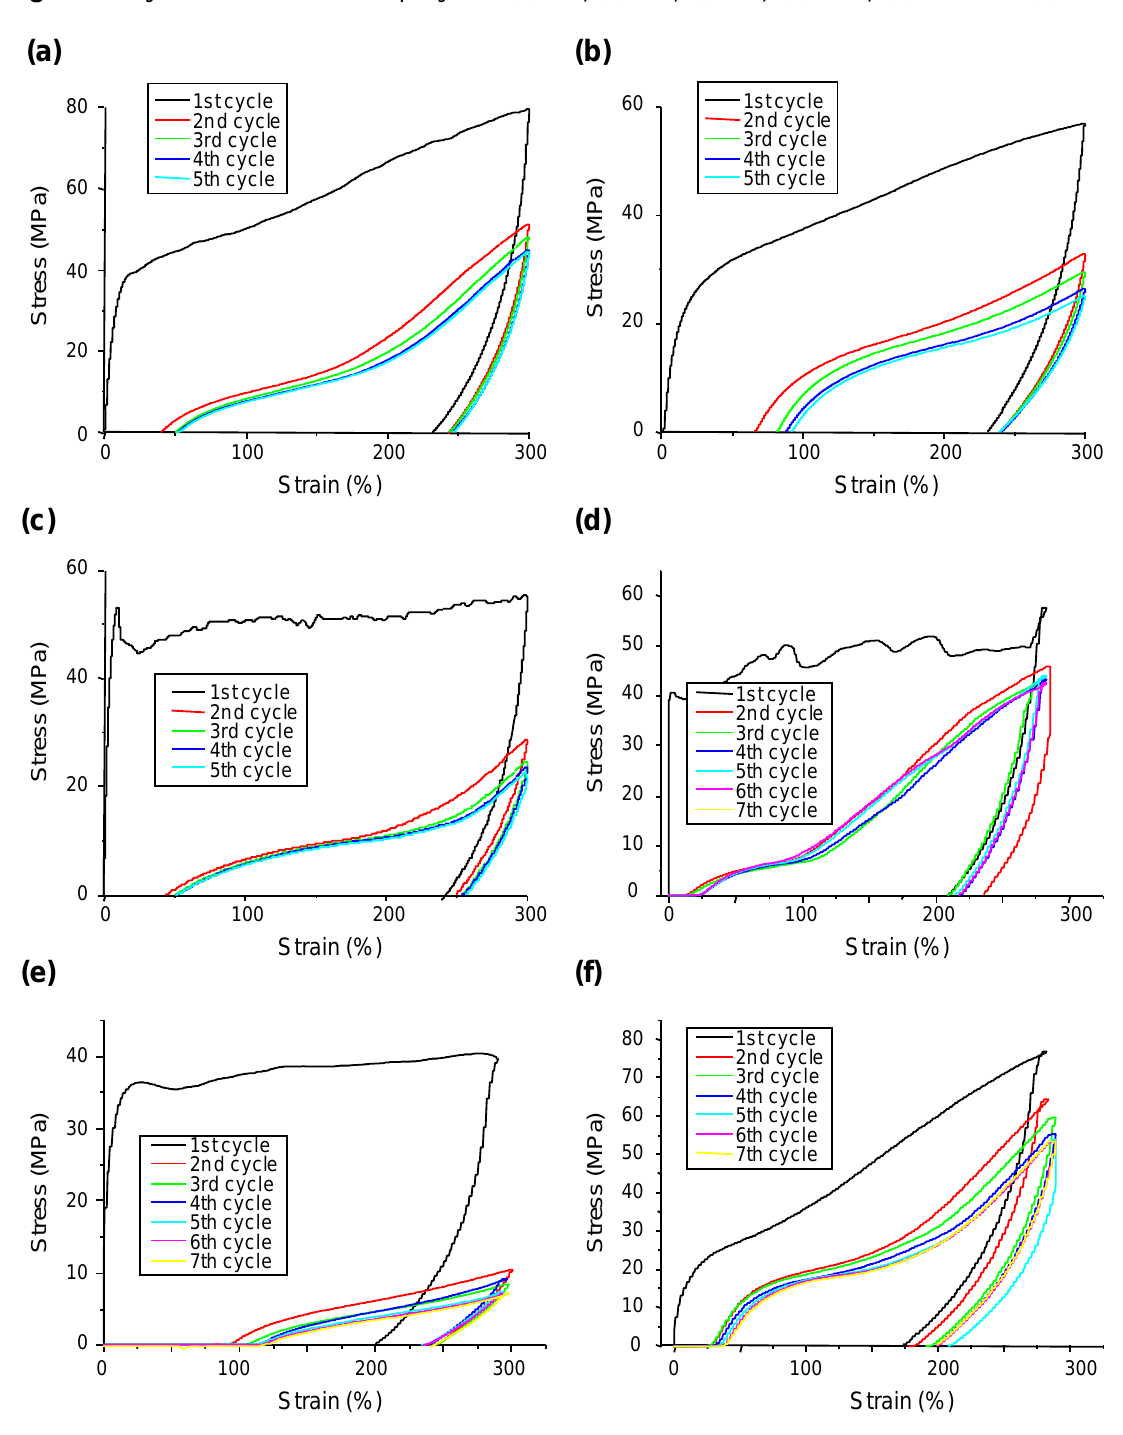
Figure 5. Cyclic tensile tests for polymer (a) P2 , (b) P6 , (c) P7 , (d) P11 , (e) P16 and (f) P18